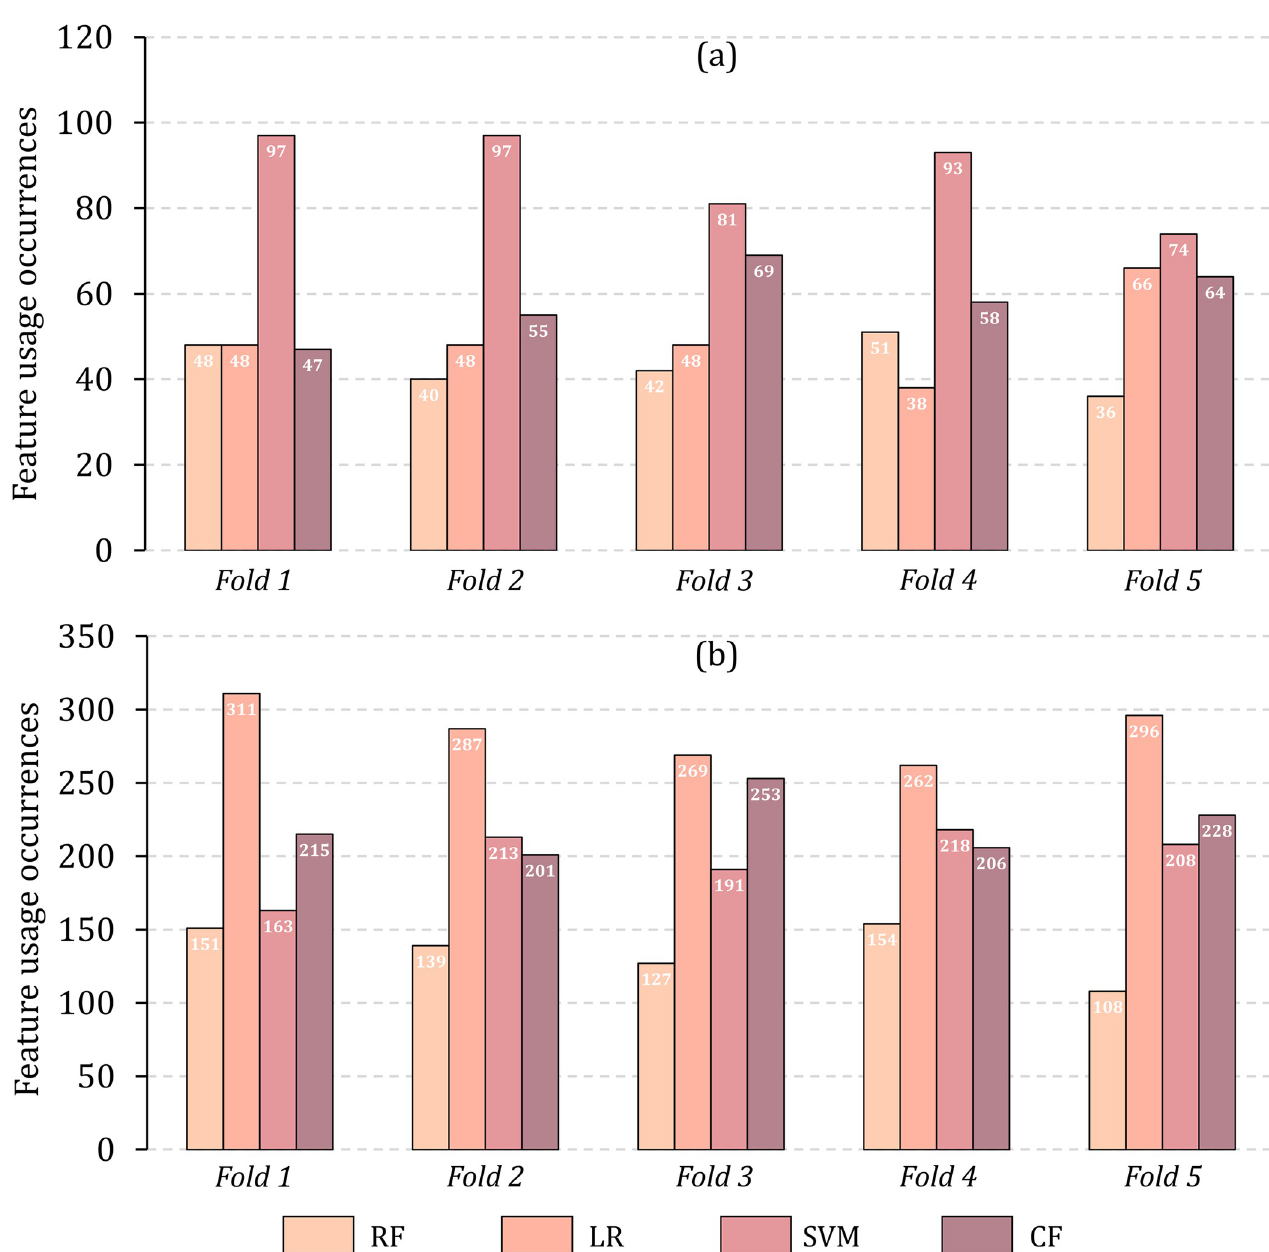
dataset via five cross- ben